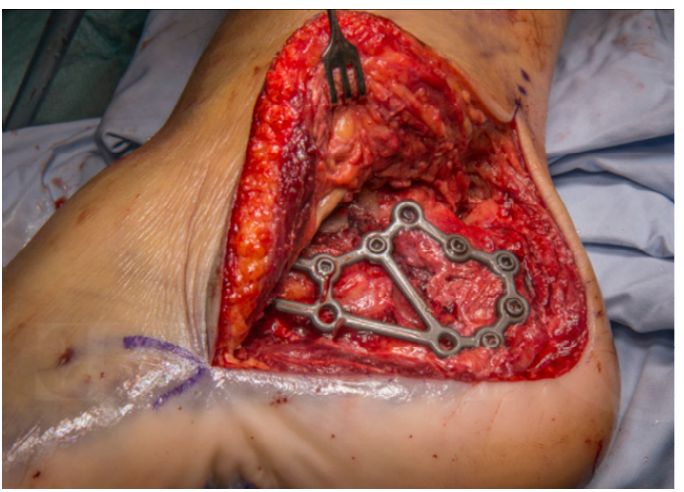
Figure 4. Lateral incision and plate application during heel bone osteosynthesis (alternative method of treatment).